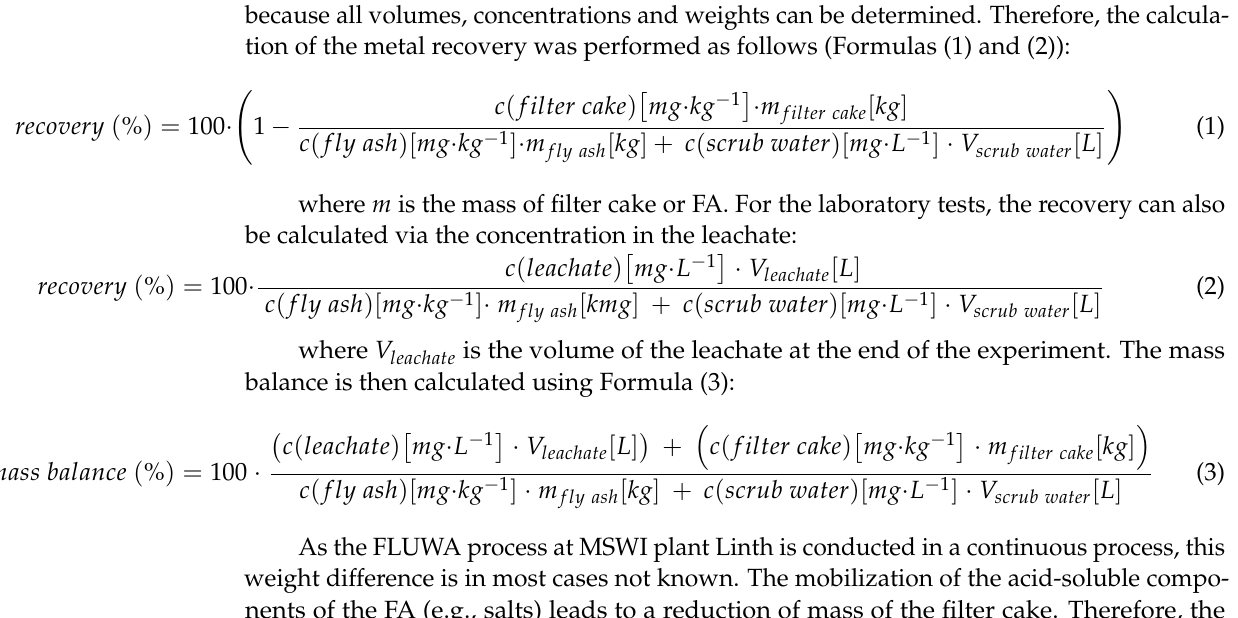
Table 3. Experimental setups for industrial-scale experiments. Parameter. pH Redox (L/t H 2 O 2 ) L/S (m 3 /t) Experiment A 6 0 3 Experiment B 4.5 Experiment